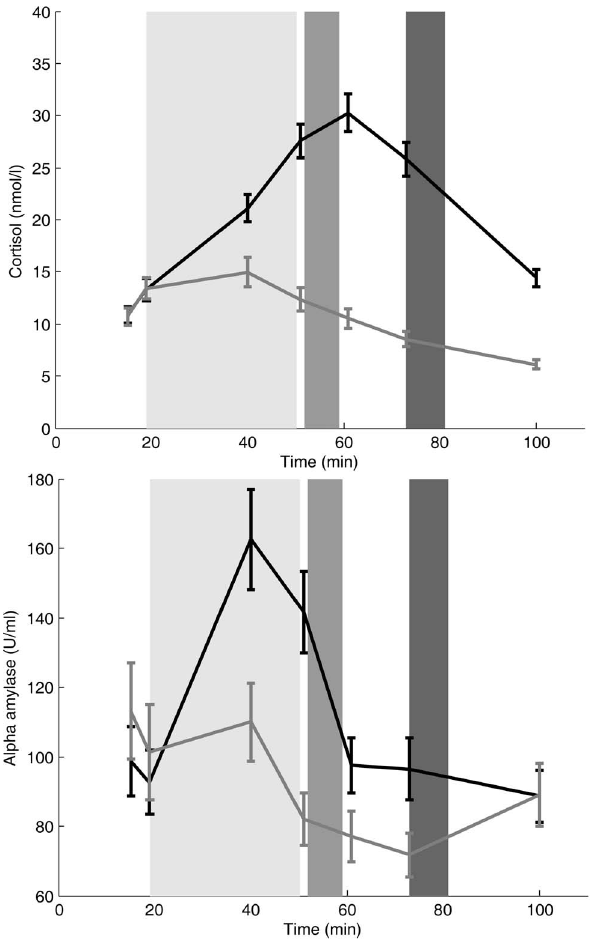
Figure 1. Experimental timeline and cortisol and effects of psychosocial stress on salivary cortisol (A) and alpha-amylase (B) levels. Subjects were subjected to a group-wise Trier Social Stress Test (TSST-G) or a control task, which lasted 30 minutes (light gray region). Subsequently, they performed an intertemporal choice task lasting approximately 10 min, either immediately following the TSST-G/ Control task (medium gray region), or 20 min later (i.e. 55 min after onset of the stressful situation; dark grey region). The conducted ANOVAs revealed a significant Sample Period 6 Stress interaction for both cortisol ( A ) and alpha-amylase ( B ). * p , 0.1 in post-hoc